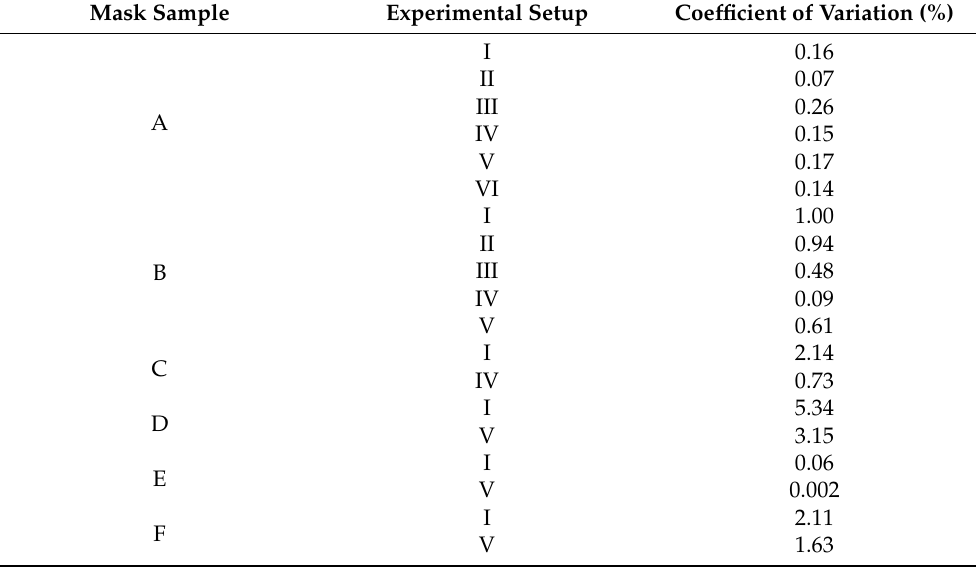
Table 2. Reproducibility of bacterial (BFE) or viral (VFE) filtration efficiency determined with different experimental setups (BFE: setups I and II; VFE: setups III–VI). The coefficient of variation (%) was calculated from all subsamples of each mask sample in the same experimental setup (A–F).